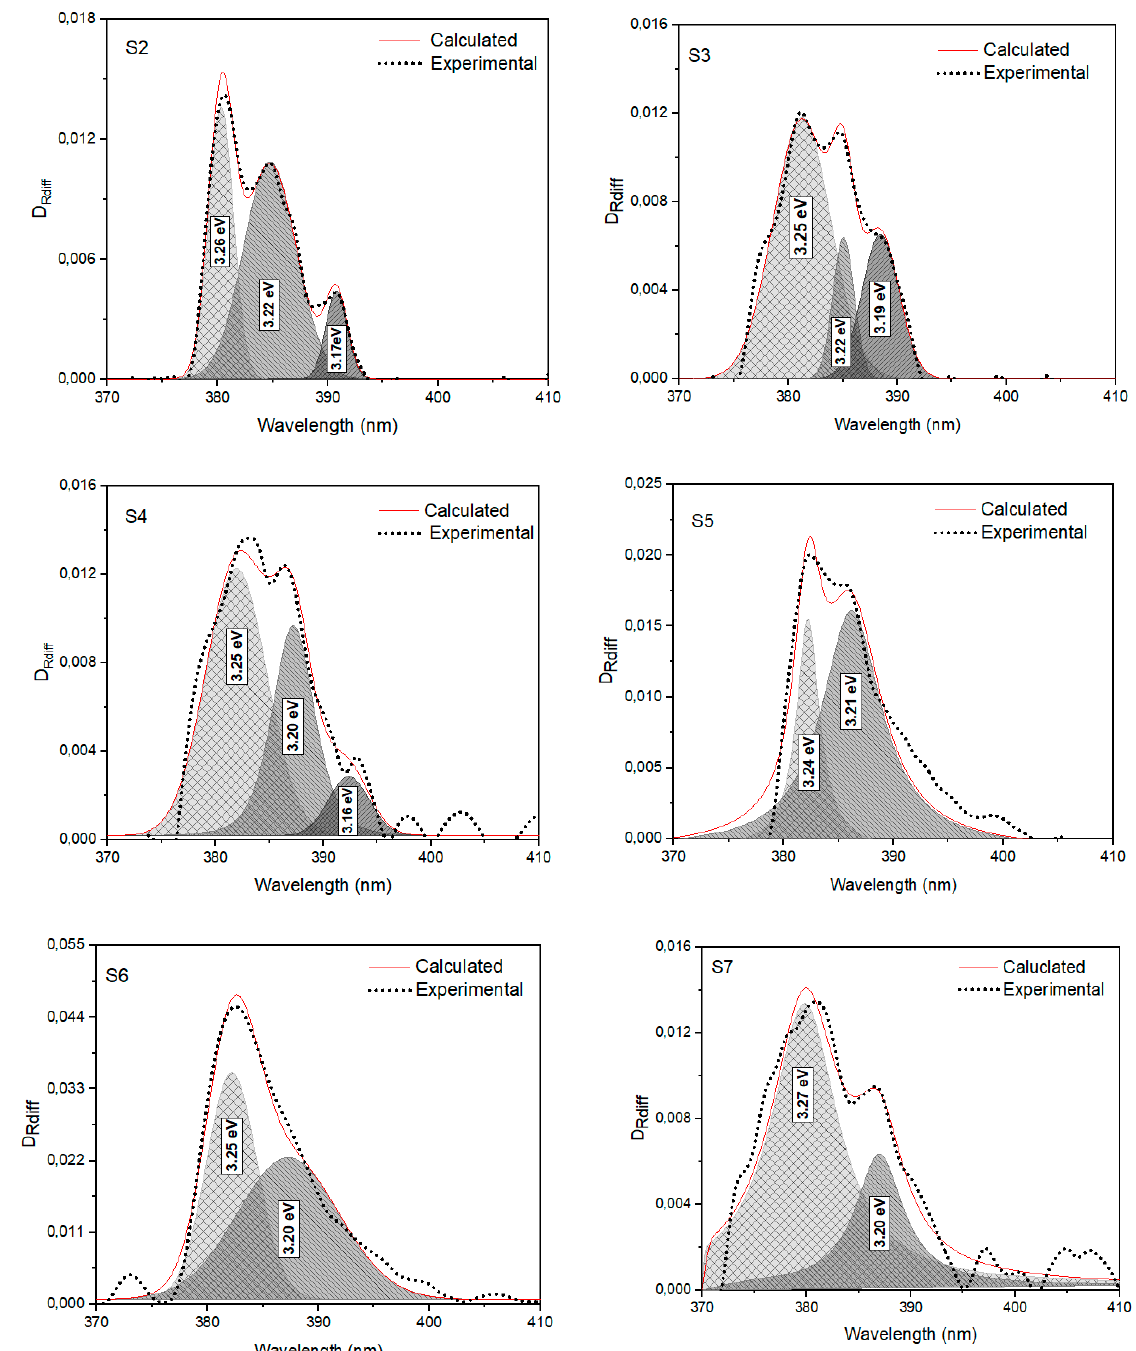
Figure 9. Deconvolution of the reflectance spectra for the pure and boron doped ZnO